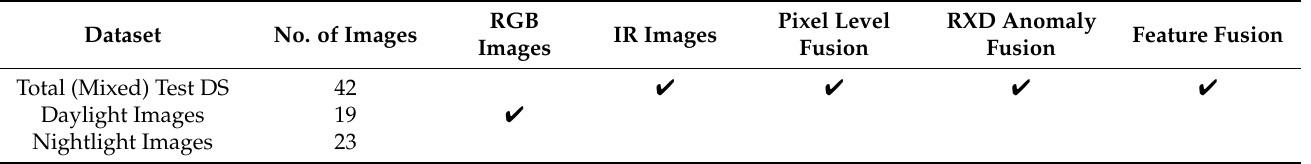
Table 2. Mixed set of images containing a total of 42 images (19 daylight images and 23 nightlight images) was created with each of the listed processes as the Test DS. RGB images were tested only on daylight